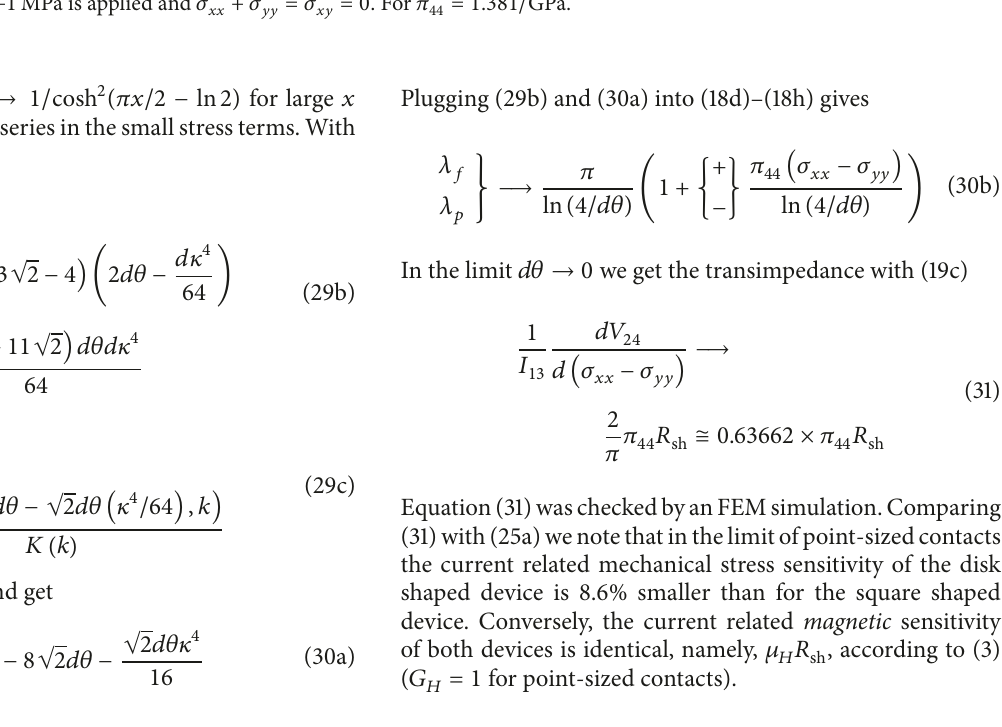
10 Figure 15: Relative change of resistances of the equivalent resistor circuit (ERC) for offset-free ( 𝜆 𝑓0 = 𝜆 𝑝0 ) symmetric circular devices from Figure 12. 𝜎 = 𝜎 𝑥𝑥 − 𝜎 𝑦𝑦 = −1 MPa is applied and 𝜎 𝑥𝑥 + 𝜎 𝑦𝑦 = 𝜎 𝑥𝑦 = 0 . For 𝜋 44 = 1.381/ GPa.